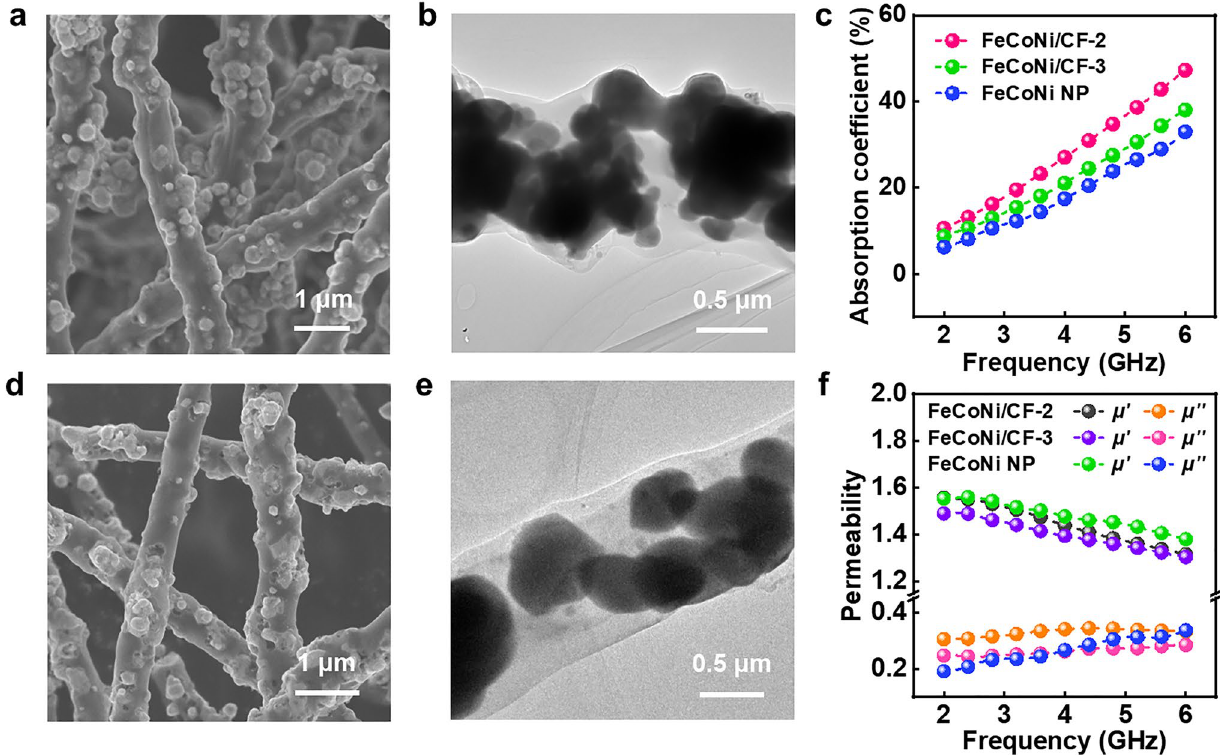
Fig. 5 a SEM and b TEM images of FeCoNi/CF-2. c The absorption coefficient of FeCoNi/CF-2, FeCoNi/CF-3 and FeCoNi NP at thickness of 2 mm. d SEM and e TEM images of FeCoNi/CF-3. f Permeability of FeCoNi/CF-2, FeCoNi/CF-3 and FeCoNi